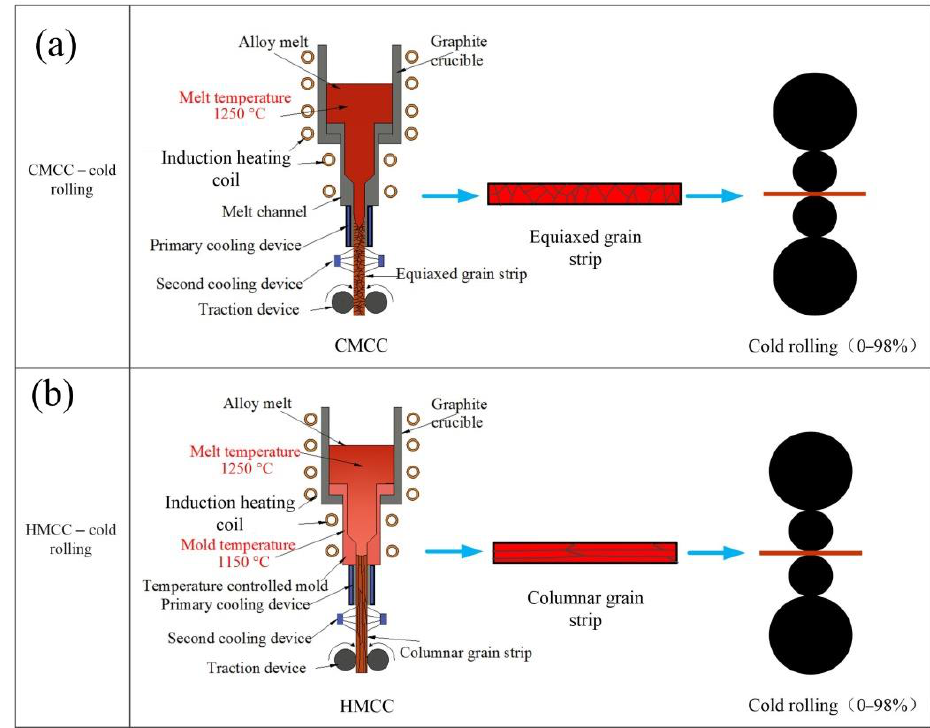
Figure 1. Schematic diagram of strip preparation and cold rolling process. ( a ) CMCC-cold rolling; ( b ) HMCC-cold rolling.